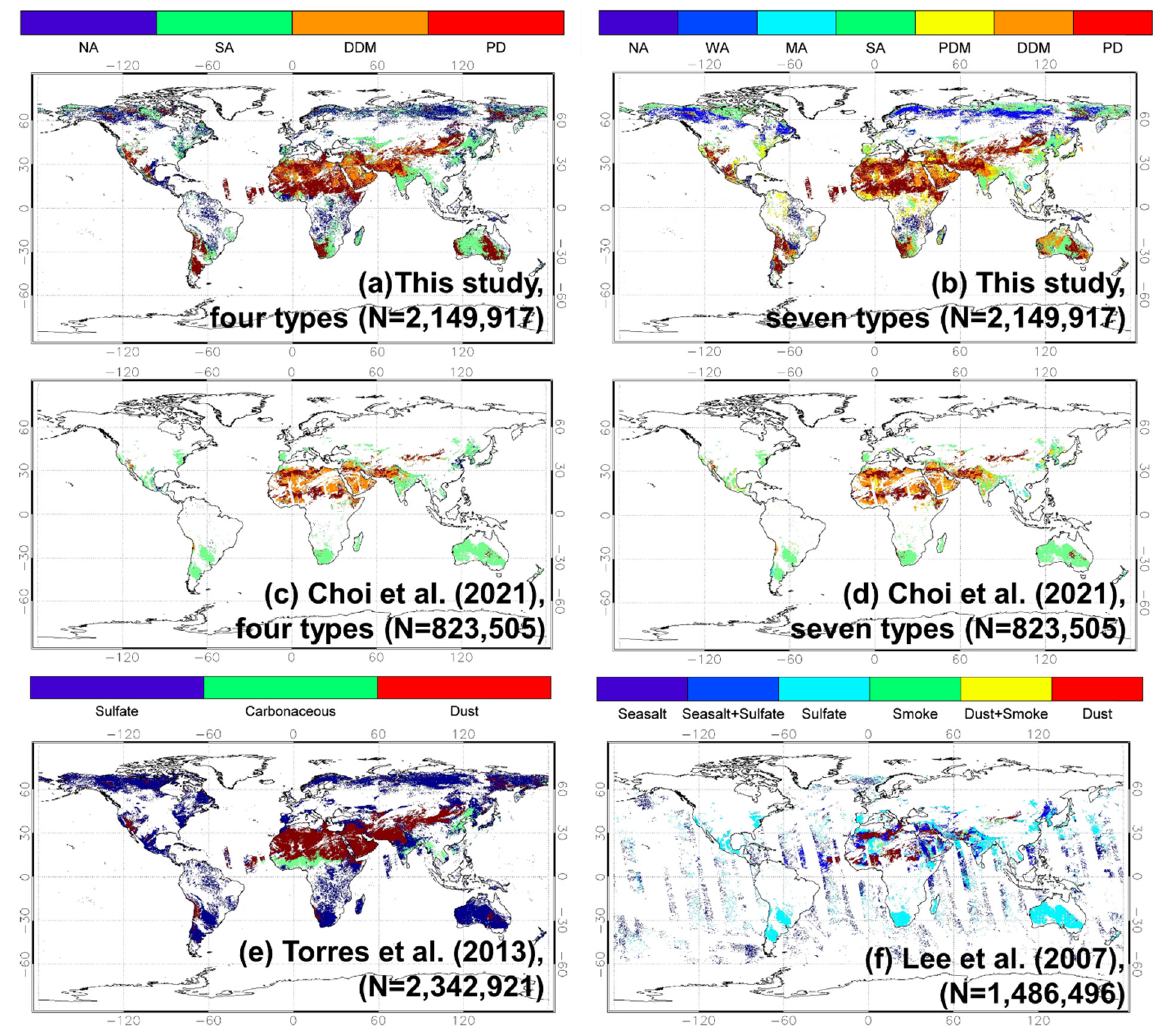
Figure 5. Comparisons of spatial distributions of aerosol types classified from ( a ) RF-based algorithm with a reduced number of input variables in this study (four type classification), ( b ) RF-based algorithm with a reduced number of input variables in this study (seven type classification), ( c ) RF-based algorithm in Choi et al. [25] (four type classification), ( d ) RF-based algorithm in Choi et al. [25] (seven type classification), ( e ) Torres et al. [9], and ( f ) Lee et al. [12] on 26 March